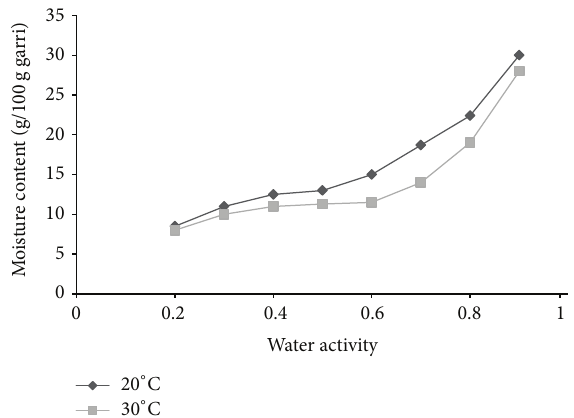
Figure 2: Moisture sorption isotherm of white garri at 20 ∘ C and 30 ∘ C.